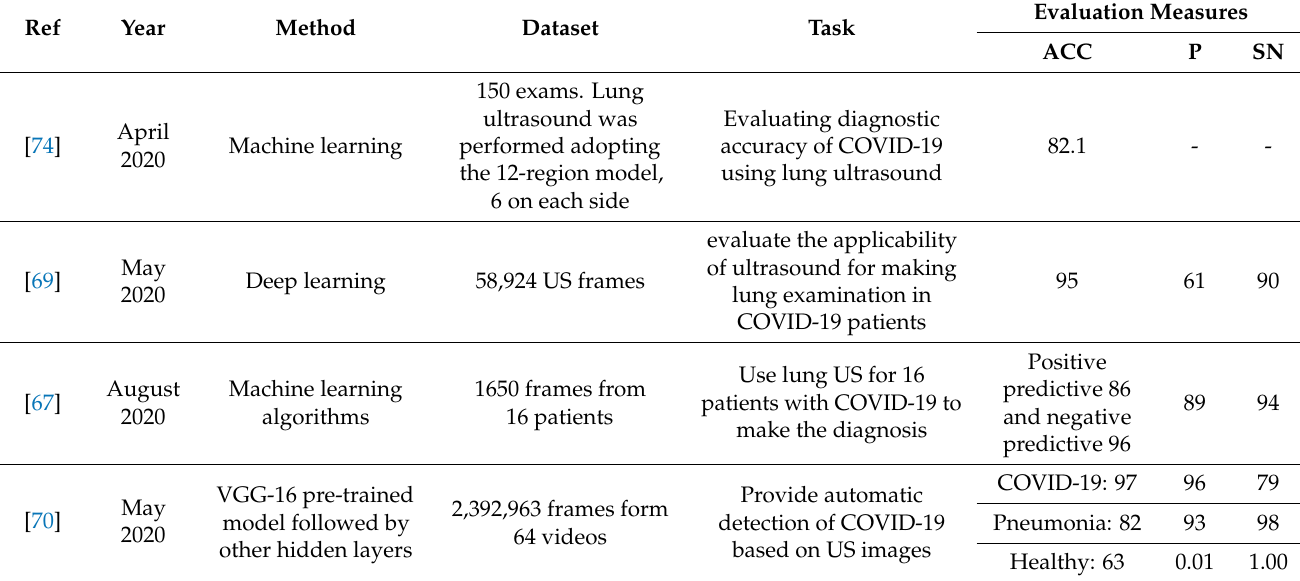
Table 4. A comparison of ultrasound-based AI research for classifying COVID-19